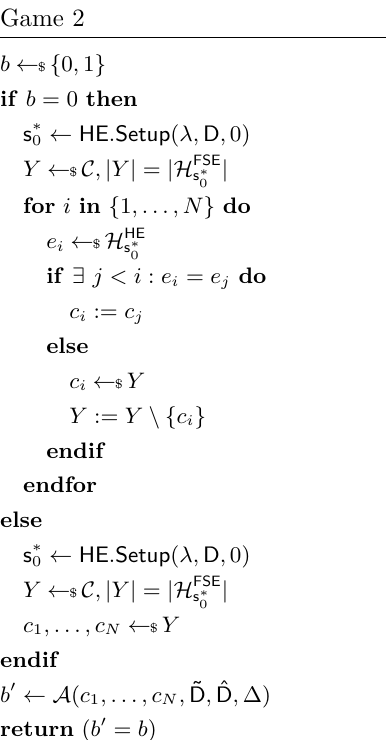
Figure 5: Sequence of games in the proof of smoothness of an ( HE , DE )- FSE scheme (continued from previous